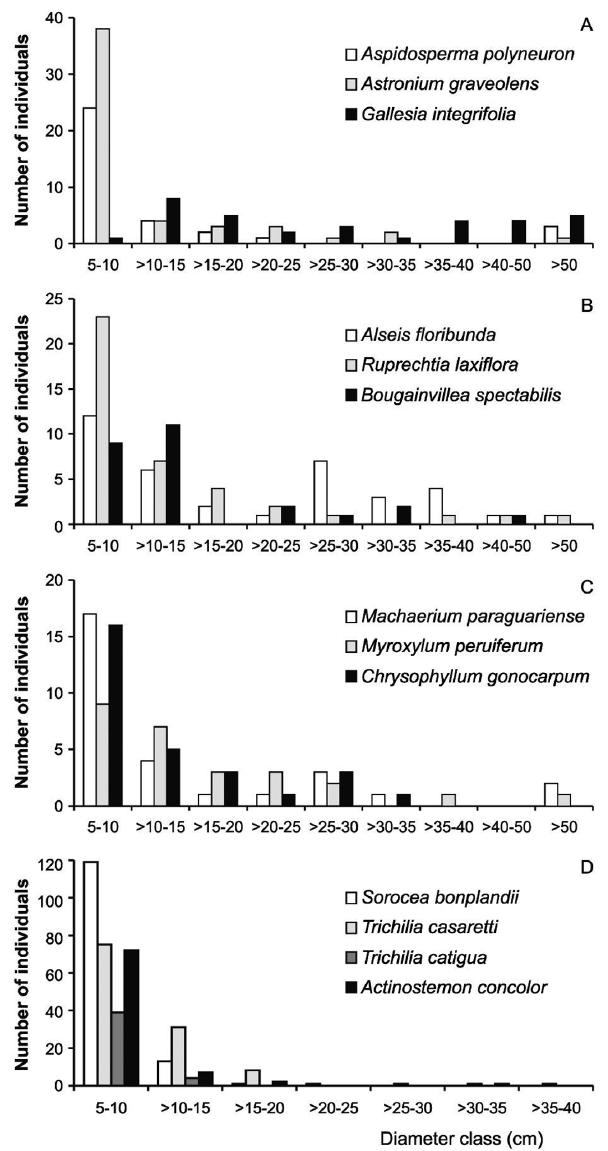
Fig. 1 – Diameter class distribution of individuals of tree species in a riparian forest fragment in Fazenda Doralice, Ibiporã, Paraná State, Brazil. A – emergent trees; B – shade-intolerant canopy trees; C – shade-tolerant canopy trees; D – small understory